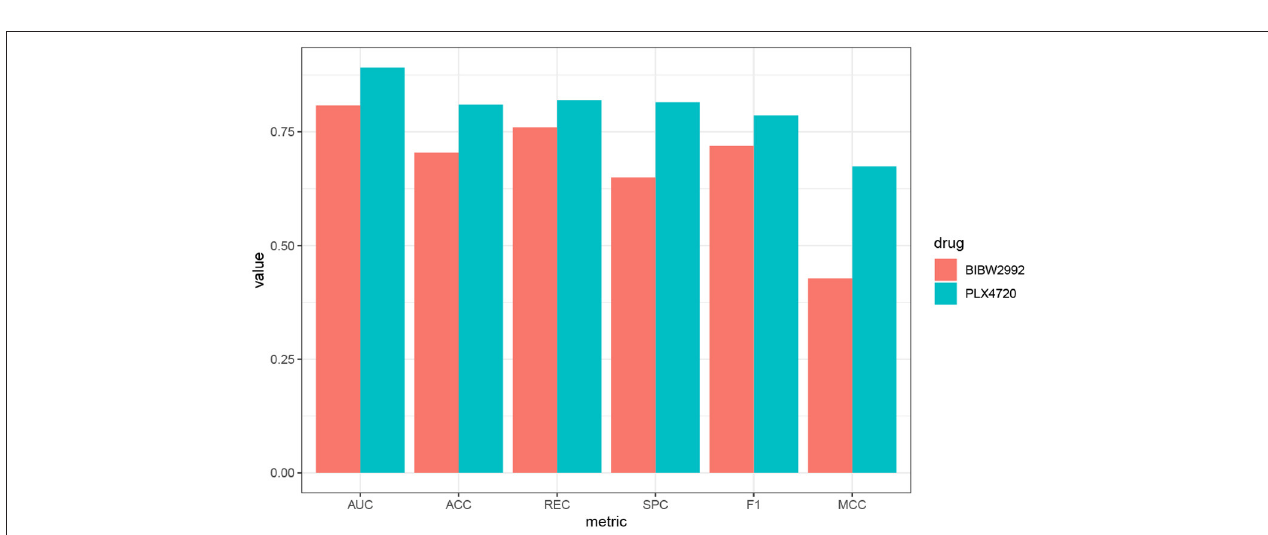
FIGURE 5 | Performance metrics of AutoBorutaRF overall the lung cell lines in GDSC for PLX4720 and BIBW2992.